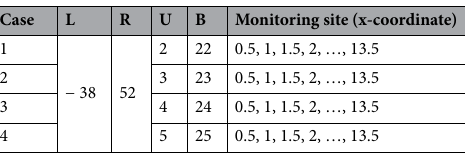
Table 3. Details of the effects of karst on different positions of tunnel floor.